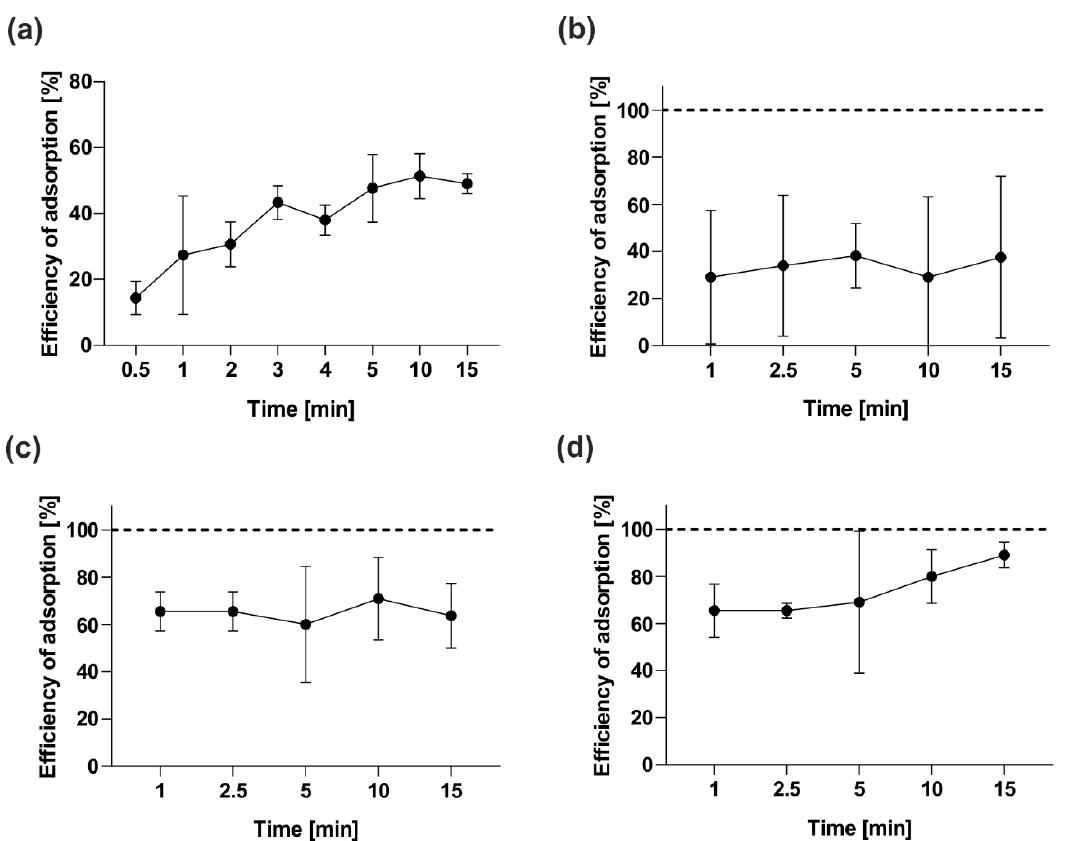
Figure 4. Adsorption efficiency of the vB_OspM_OC and vB_OspP_OH phages. The experiment with an overnight culture of Ochrobactrum sp. POC9 infected by vB_OspP_OH and vB_OspM_OC is shown on panels ( a ) and ( b ), respectively. In the case of vB_OspM_OC, tests were also performed using the POC9 cultures with OD 600 = 0.2 ( c ) and OD 600 = 0.4 ( d ). The presented results are the average values from three experiments, with standard deviation represented by the error bars.